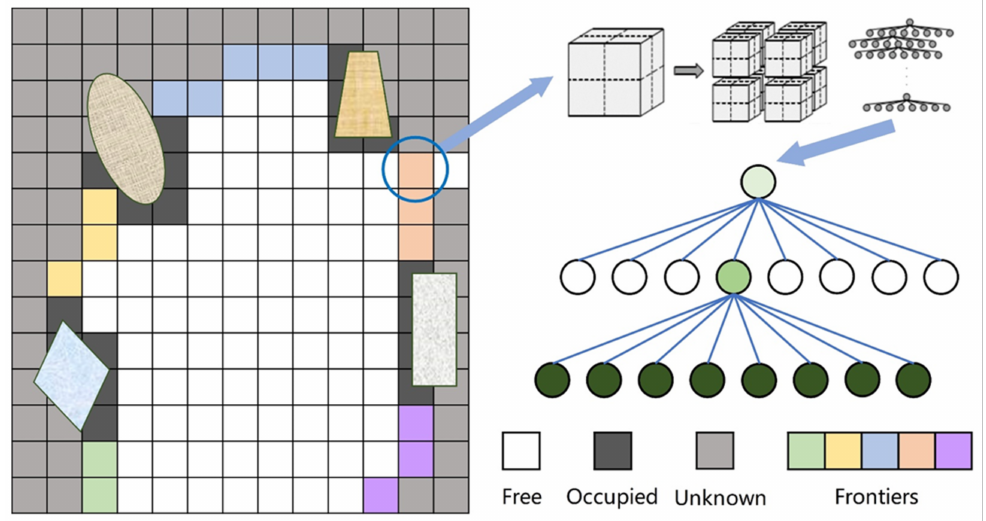
Figure 5. An illustration of frontier detection and clustering workflow. Occupancy mapping with Supereight model shows in right hand of